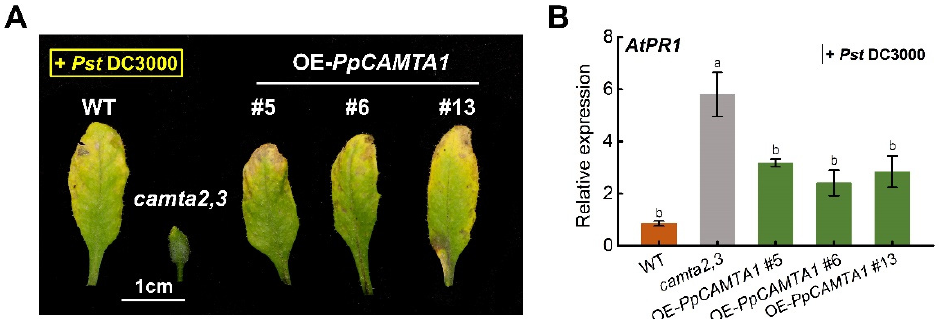
Figure 9. Overexpression of PpCAMTA1 in camta2,3 mutant affects plant response to Pst DC3000. ( A ) Photos of 4-week-old plants leaves at 3 days post-inoculation (3 dpi) with the spray of Pst DC3000. ( B ) Transcript level of PR1 after 1 dpi with the spray of Pst DC3000. Means and standard errors were calculated from three replicates. Different letters above the bars represent significant differences ( p < 0.05).